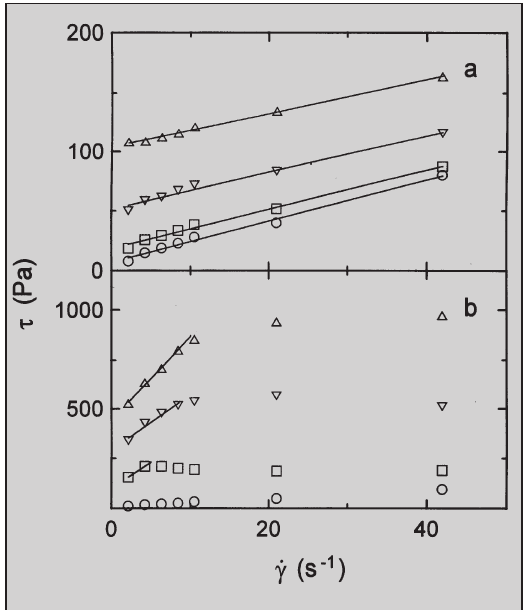
Figure 1 (left): Dependence of the apparent viscosity, η, of the suspen- sion in silicon oil SO100 on the shear rate, γ · (DC electric field, at 2 kV/mm; Gap width (mm): 1 ( Ô ),1.5 ( Ó ).